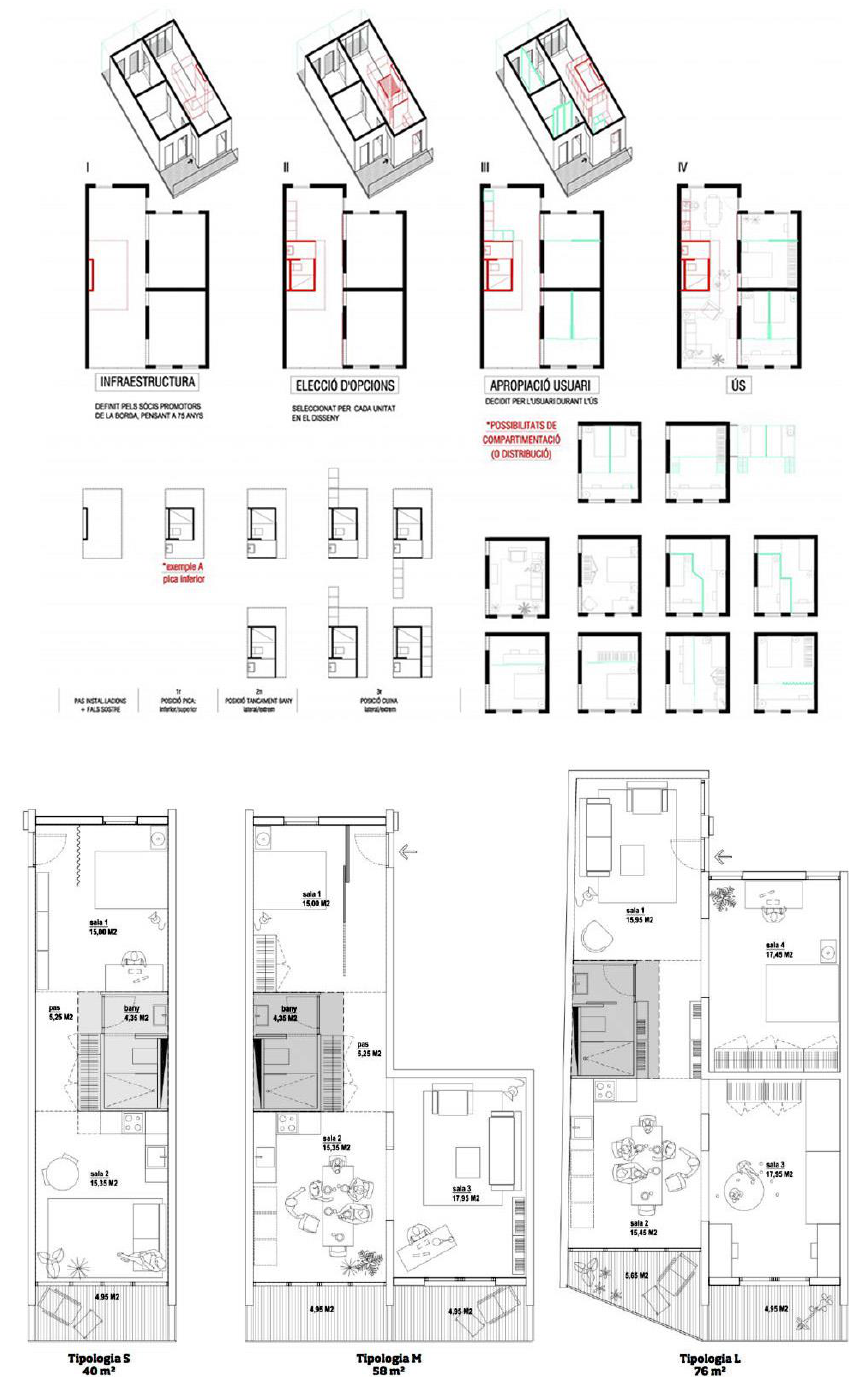
Figure 4. Dwellings variation. Top: customization of the dwelling layout by users. Below: S, M, L dwelling types Source: Courtesy of Lacol.